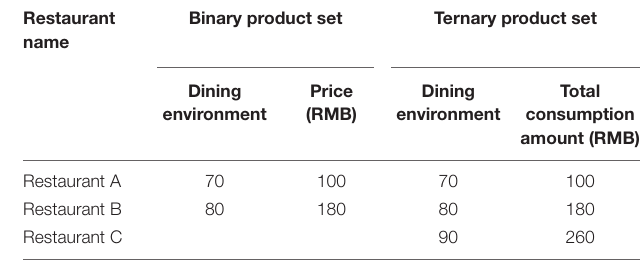
TABLE 3 | Compromise effect experimental product set.